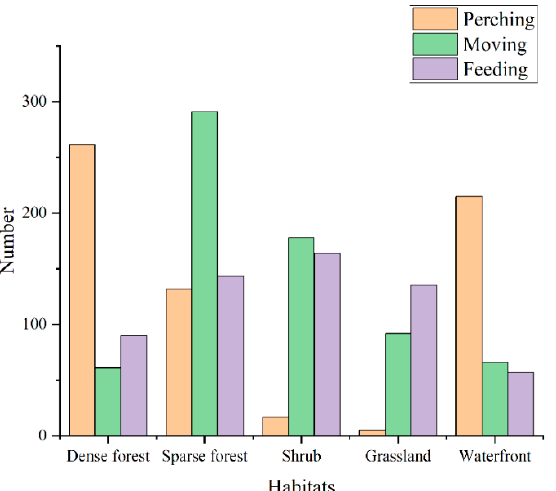
Figure 3. Distribution of different behavioral types of birds in different vegetation habitats in urban mountain parks.